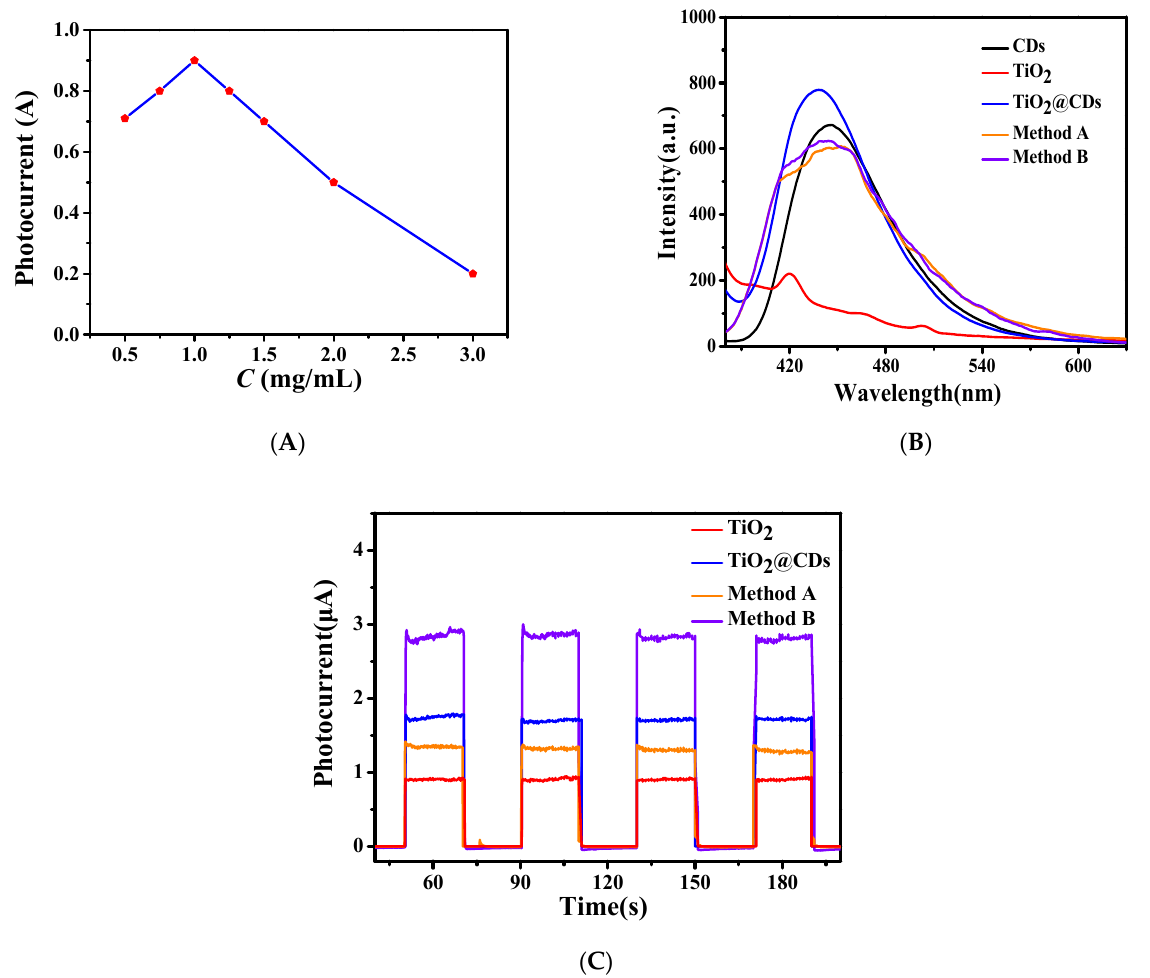
Figure 3. ( A ) Photocurrent of the electrodes prepared with different concentrations of TiO 2 , ( B ) fluorescence emission spectra, and ( C ) Photoelectrochemical (PEC) properties for different samples.